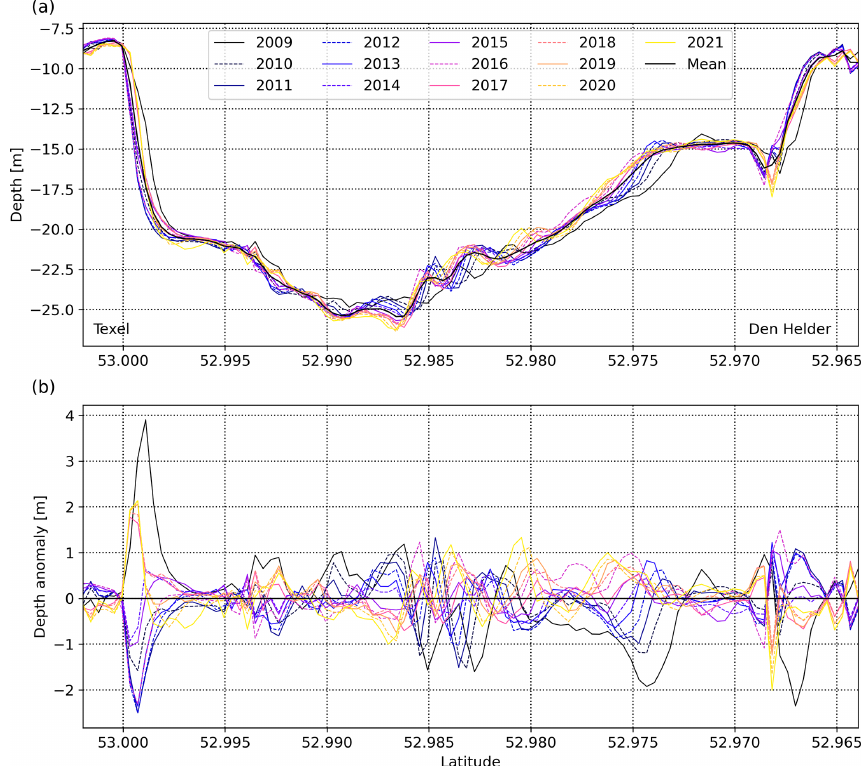
Figure 6. (a) Annual averaged depths along the transect and (b) the annual depth anomaly with respect to the 13-year